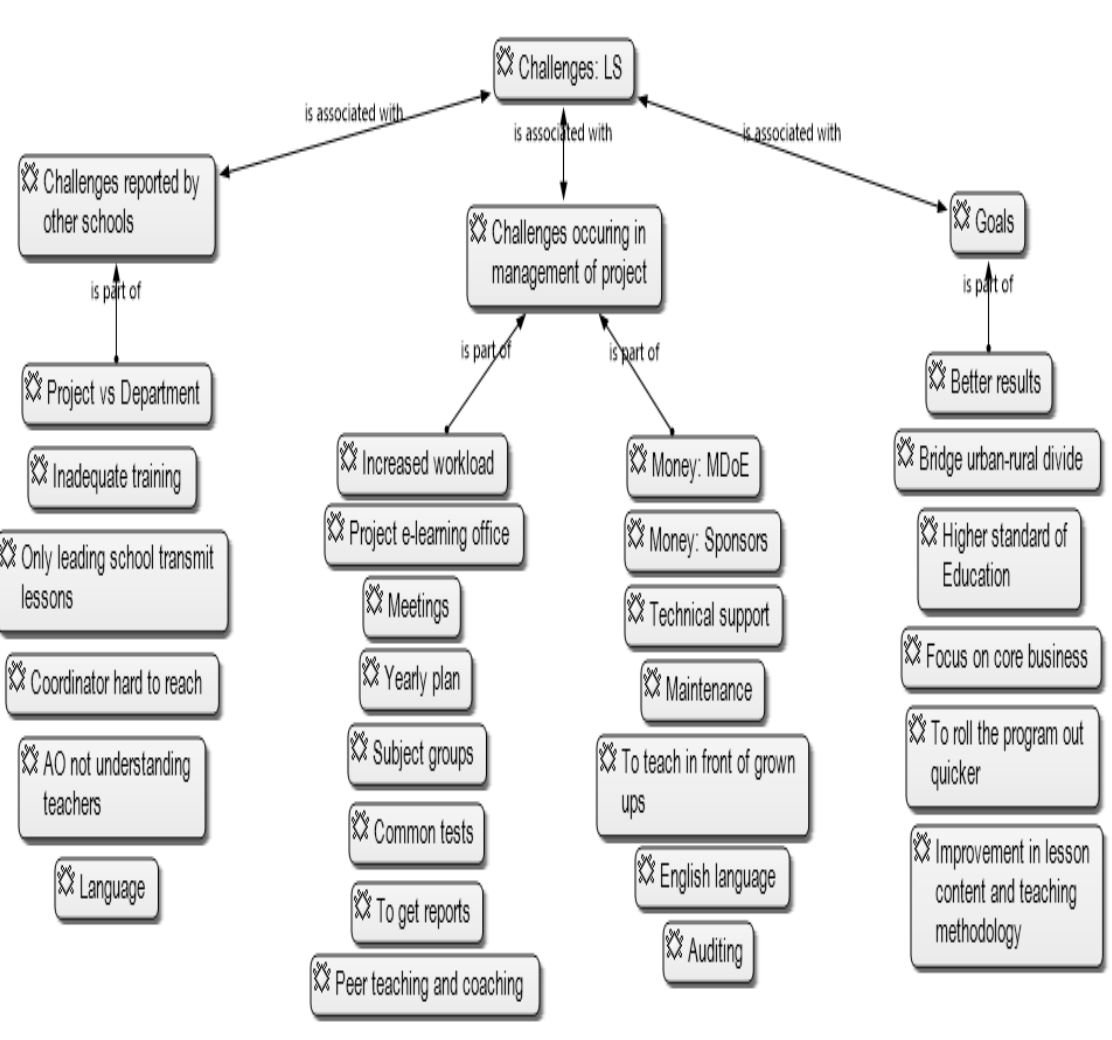
Figure 3 Management challenges of the leading